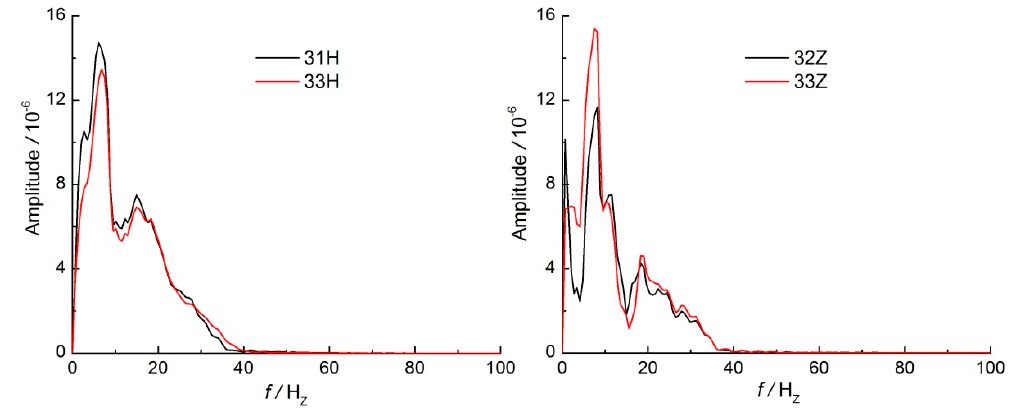
Figure 12. The spectrum of strain ( R = 2.7 m and Q = 100 g).